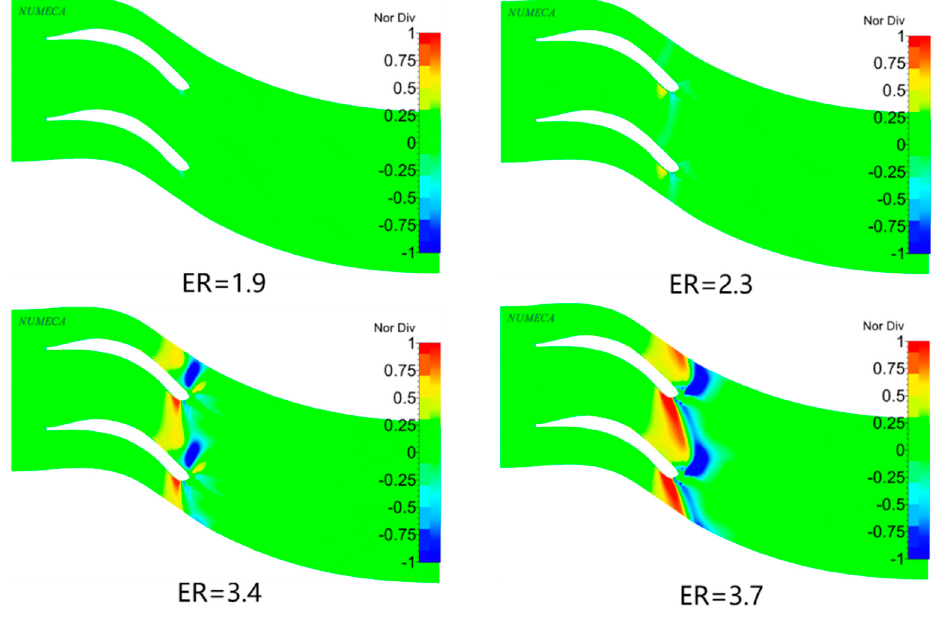
Figure 6. The distribution of dimensionless velocity divergence at different expansion ratios.